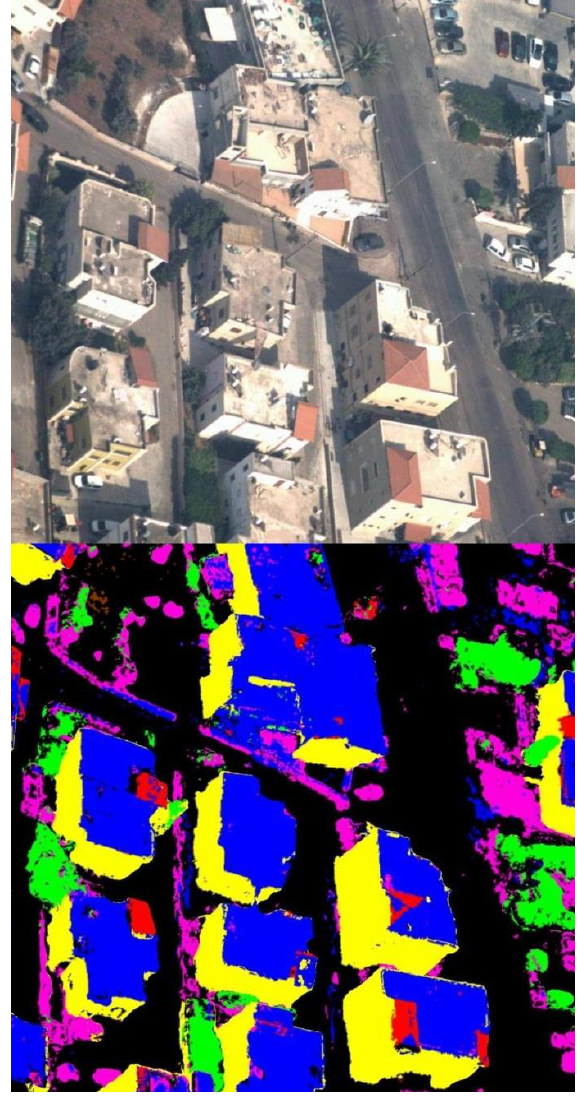
Figure 2: original image and semantic labels. Classes are roof, tiled roof, wall, ground, vegetation and car in blue, red, yellow, black, green and pink